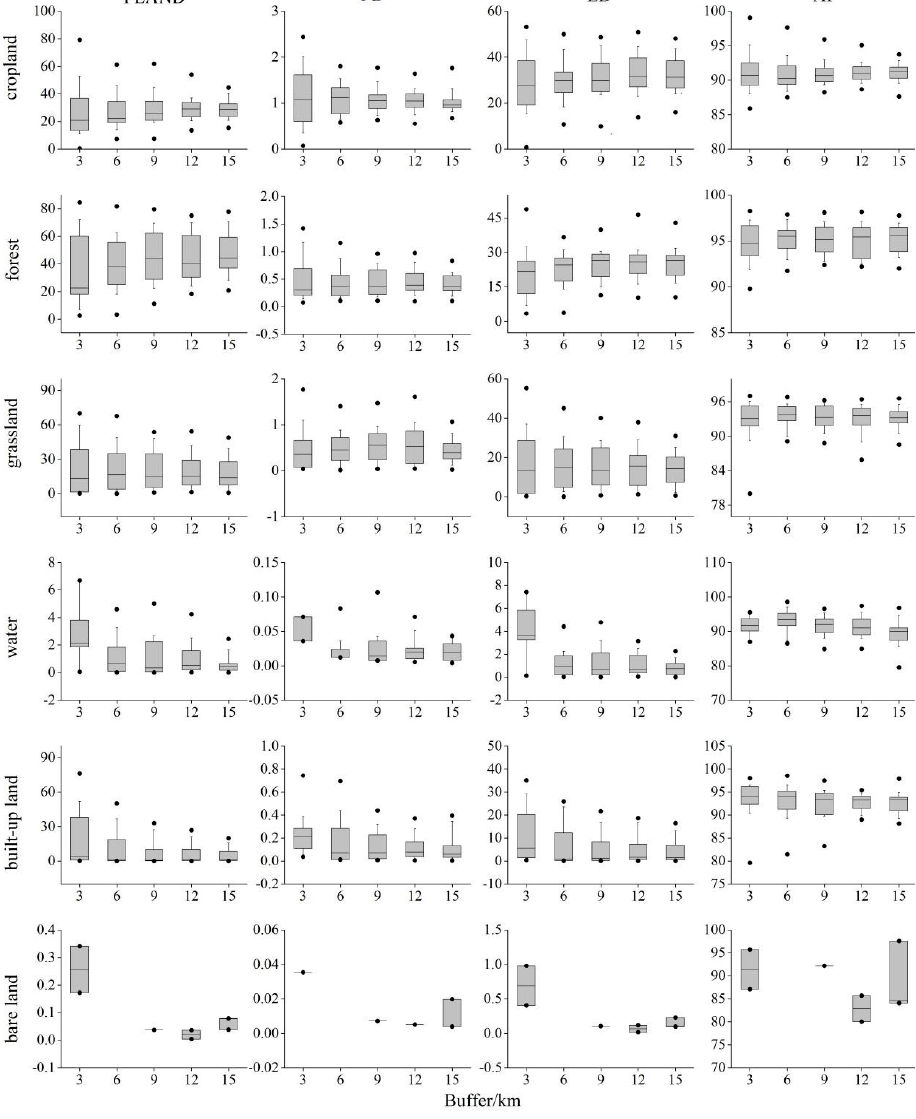
Figure 5. Class-level landscape metric indices across buffer zones (displaying value ranges for 32 sampling sites).